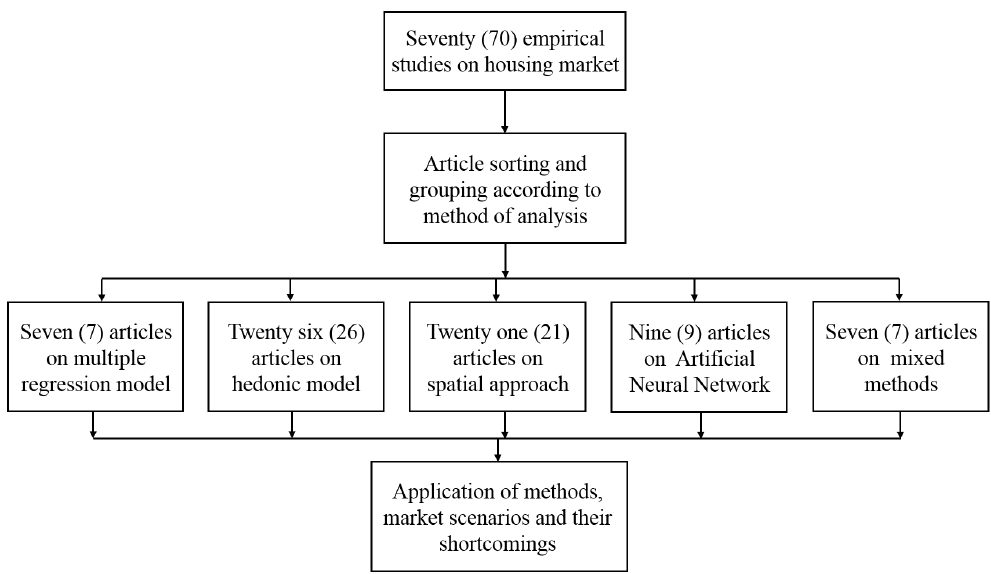
Fig. 1. Methodology and Review